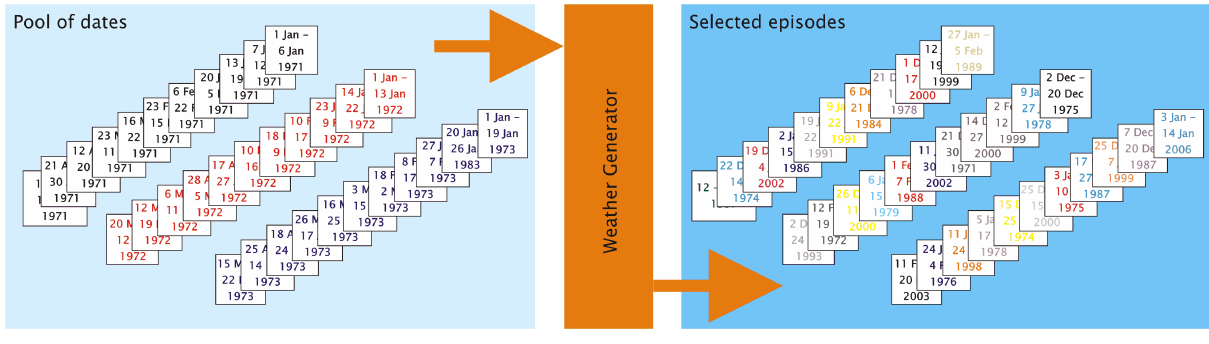
Figure 5. Schematic of the selection process. The segmentation process (Figure 4) leads to the pool of dates. The WG selects some of them according to criteria described in Section 3. Episodes are assembled to form time series ( cf. Figure